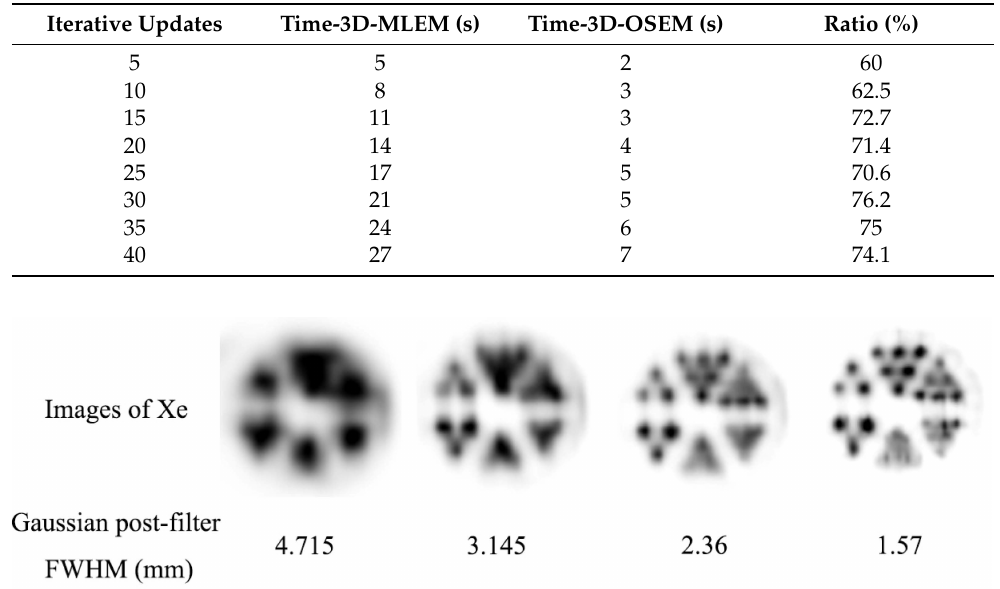
Figure 8. The PET images of the Derenzo phantom of the Xe sub-experiment using the 3D-MLEM algorithm (iteration 35) with different Gaussian post-filter